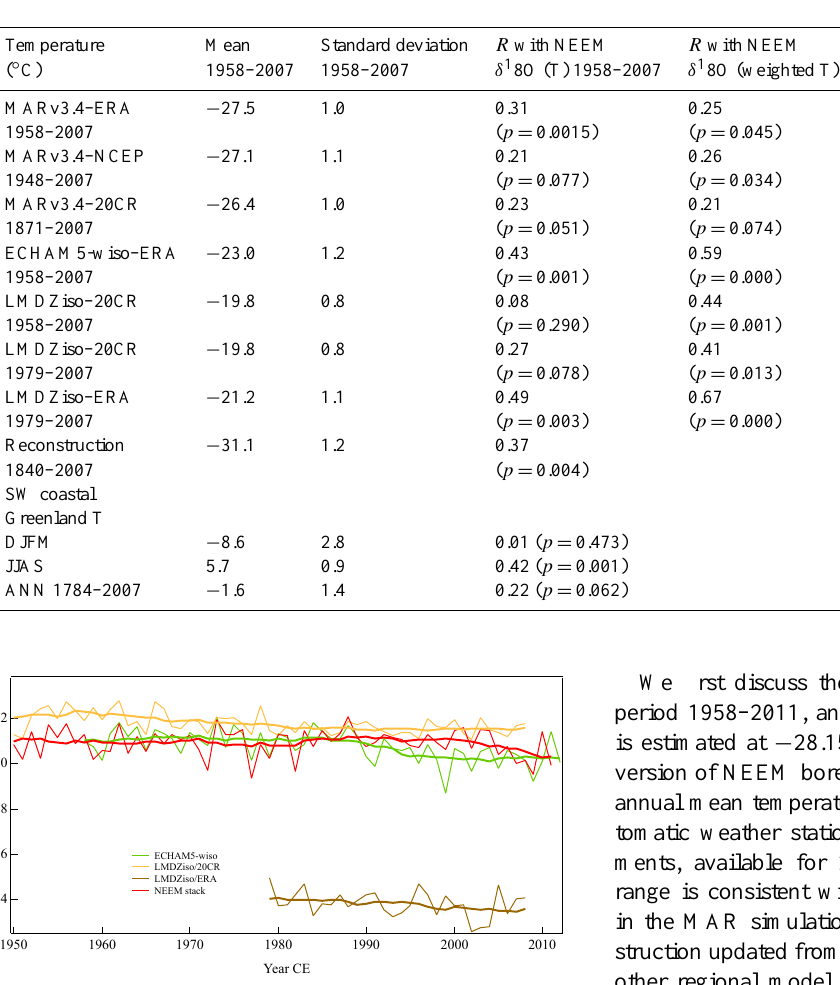
Table 5. Comparison of NEEM δ 18 O with temperature reconstructions and simulations.